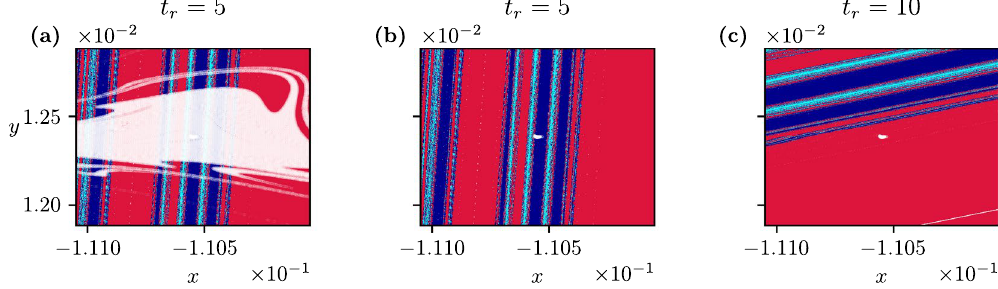
Figure 7. Patches (drawn in white) of the ensembles initiated on the full state space at t − = − 29 ( t − = − 45) in ( a ) [( b ),( c )] displayed at t = 0. The patches are laid over the scenario-dependent basins of attraction, for the scenarios t − = 0, t + = 100, C − = 0.1, C + = 0.5835 ( I 2 ) with t r given above the panels. Note the strong magnification of the basins about the cyan attractor at C − .